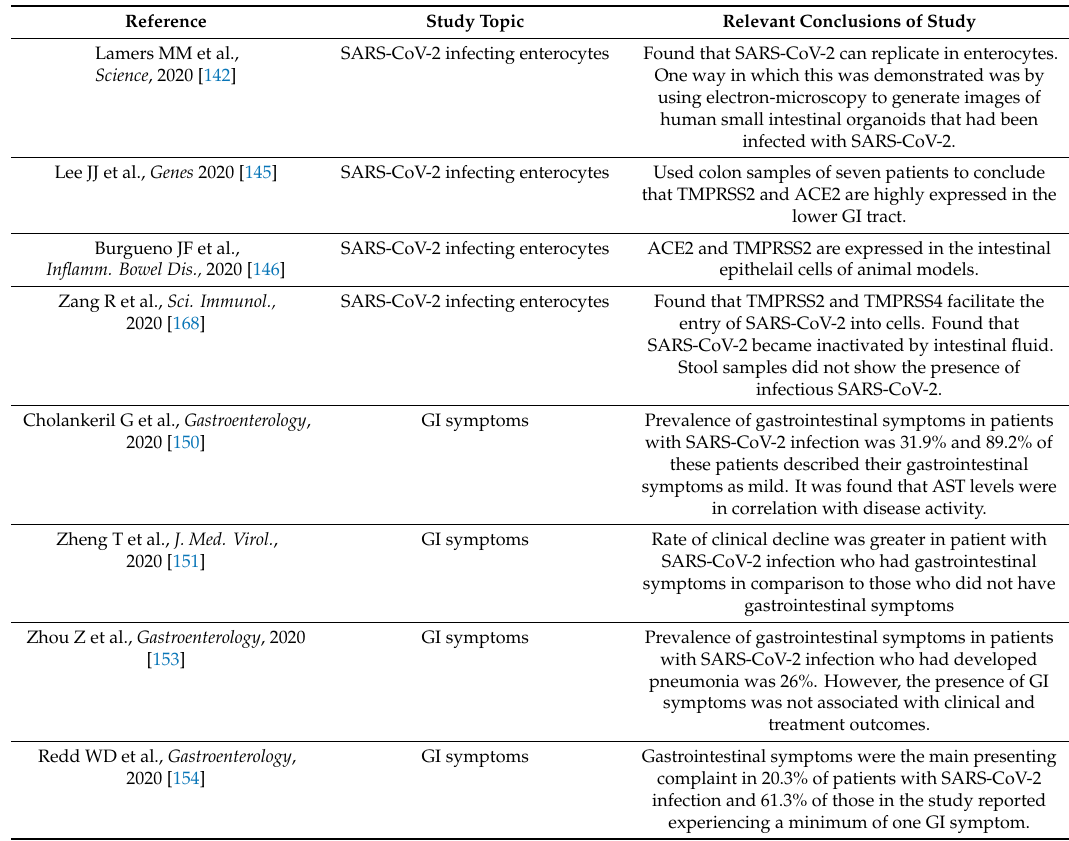
Table 3. Examples of studies that investigate the link between SARS-CoV-2 and the gastrointestinal symptoms observed in COVID-19 patients (including alterations in the